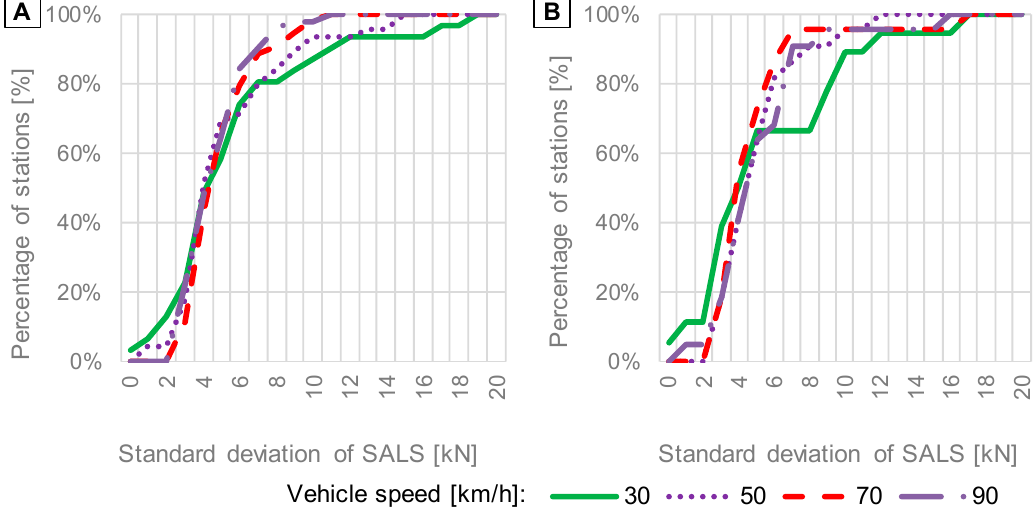
Figure 10. Distributions of standard deviations of SALS in relation to vehicle speed based on data from WIM systems equipped with: ( A ) quartz piezoelectric; ( B ) bending beam axle load sensors.